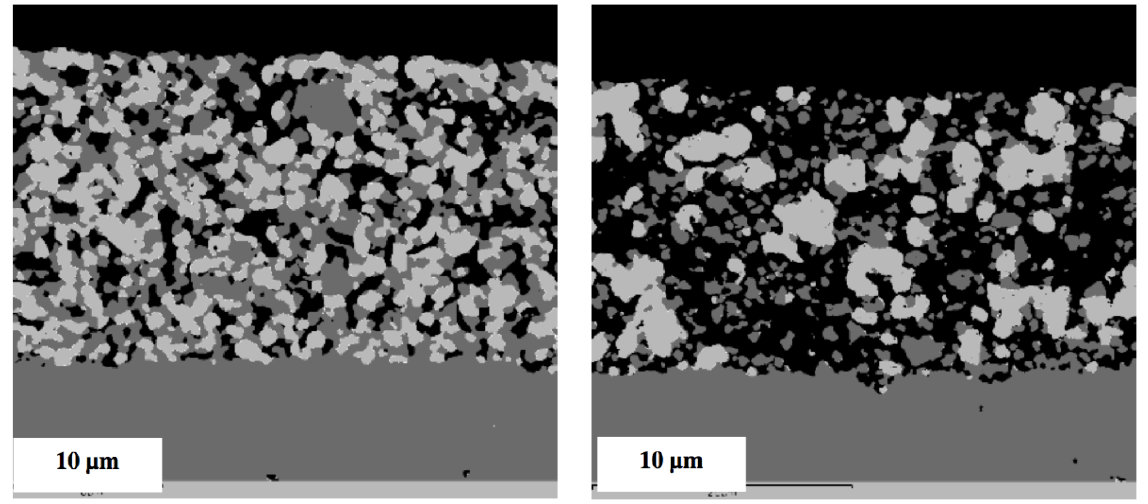
Figure 20. Fine Ni-8YSZ anode before (left) and after (right) eight RedOx cycles at 950 °C (SEM, backscattered electron detector, 10 kV)